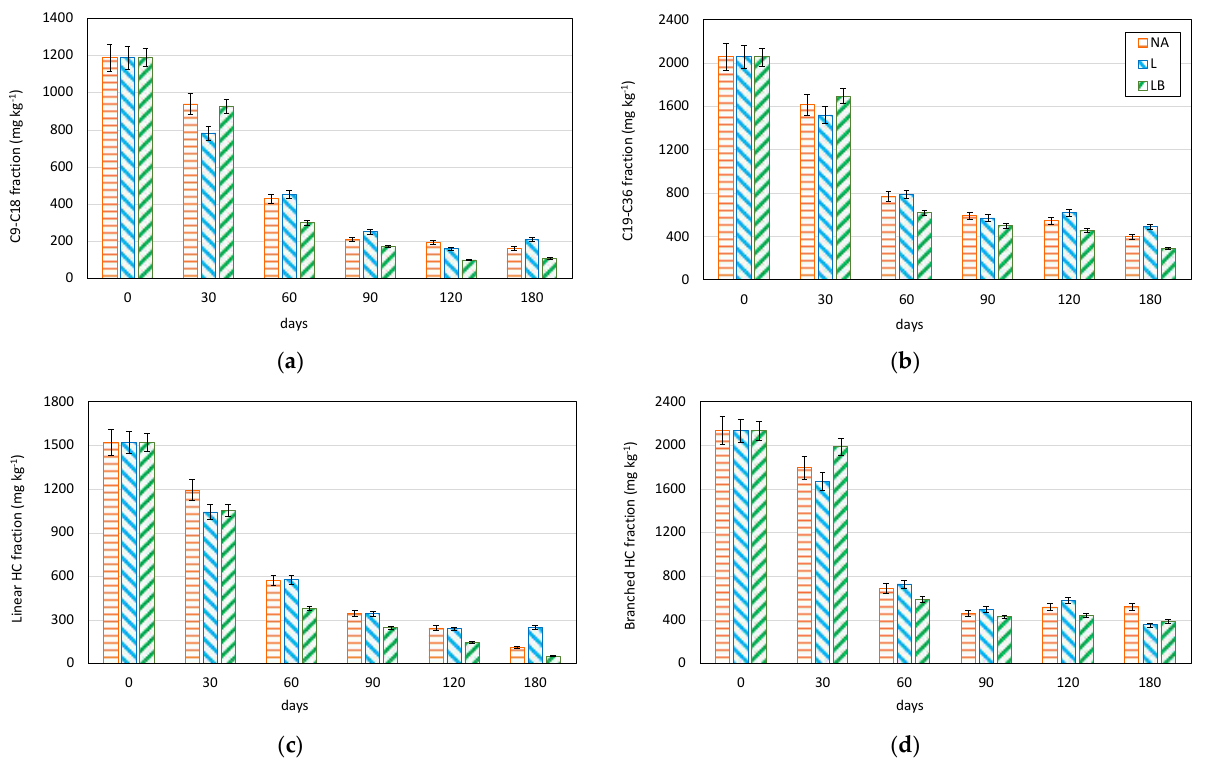
Figure 3. Evaluation of the residual content C9–C18 (a), C19–C36 (b), linear (c) and branched (d) fractions) after the different treatments (NA, L, LB) at the time of collection (30, 60, 90, 120, 180 days) in comparison to the initial content (t0). NA = natural attenuation, L = Landfarming, LB = landfarm- ing + bioaugmentation.